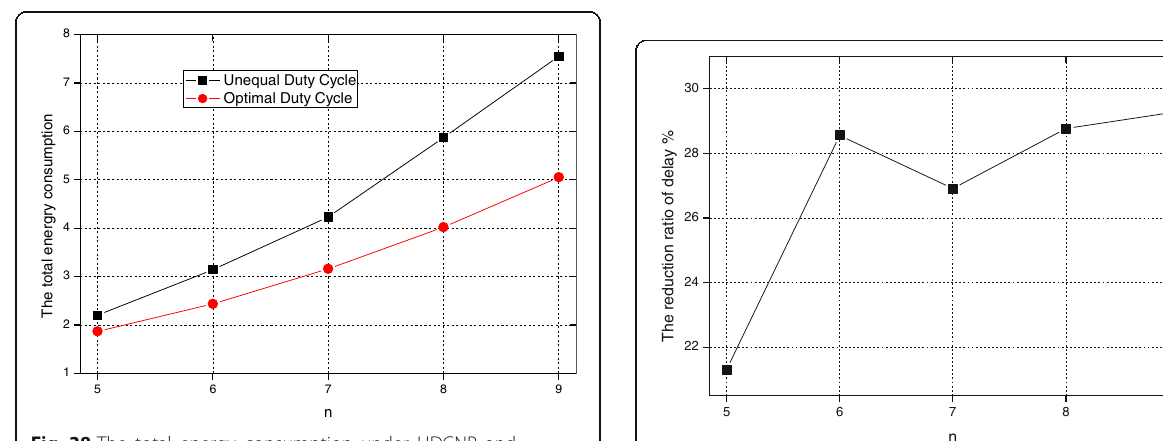
Fig. 38 The total energy consumption under UDCNP and